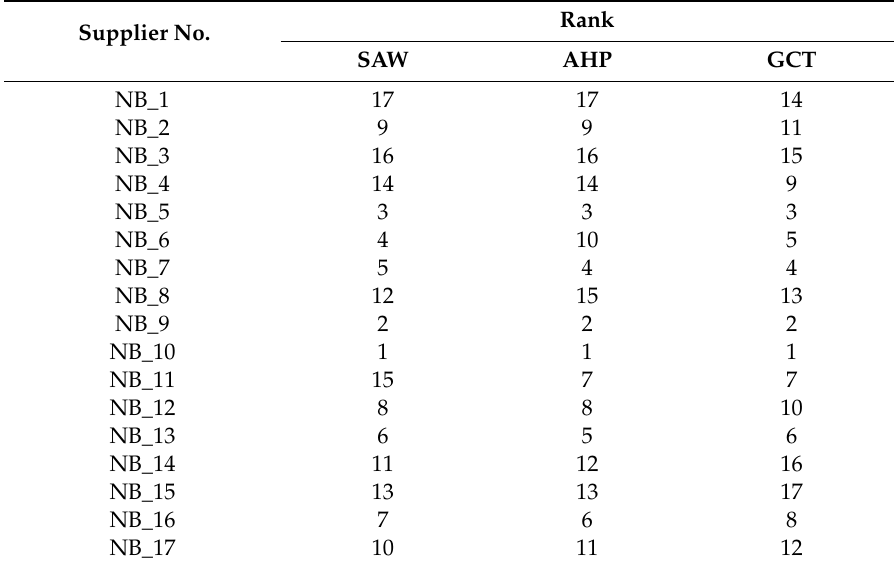
Table 6. Comparison of the proposed GCT-based algorithm with simple additive weighting and analytic hierarchy process (AHP) based